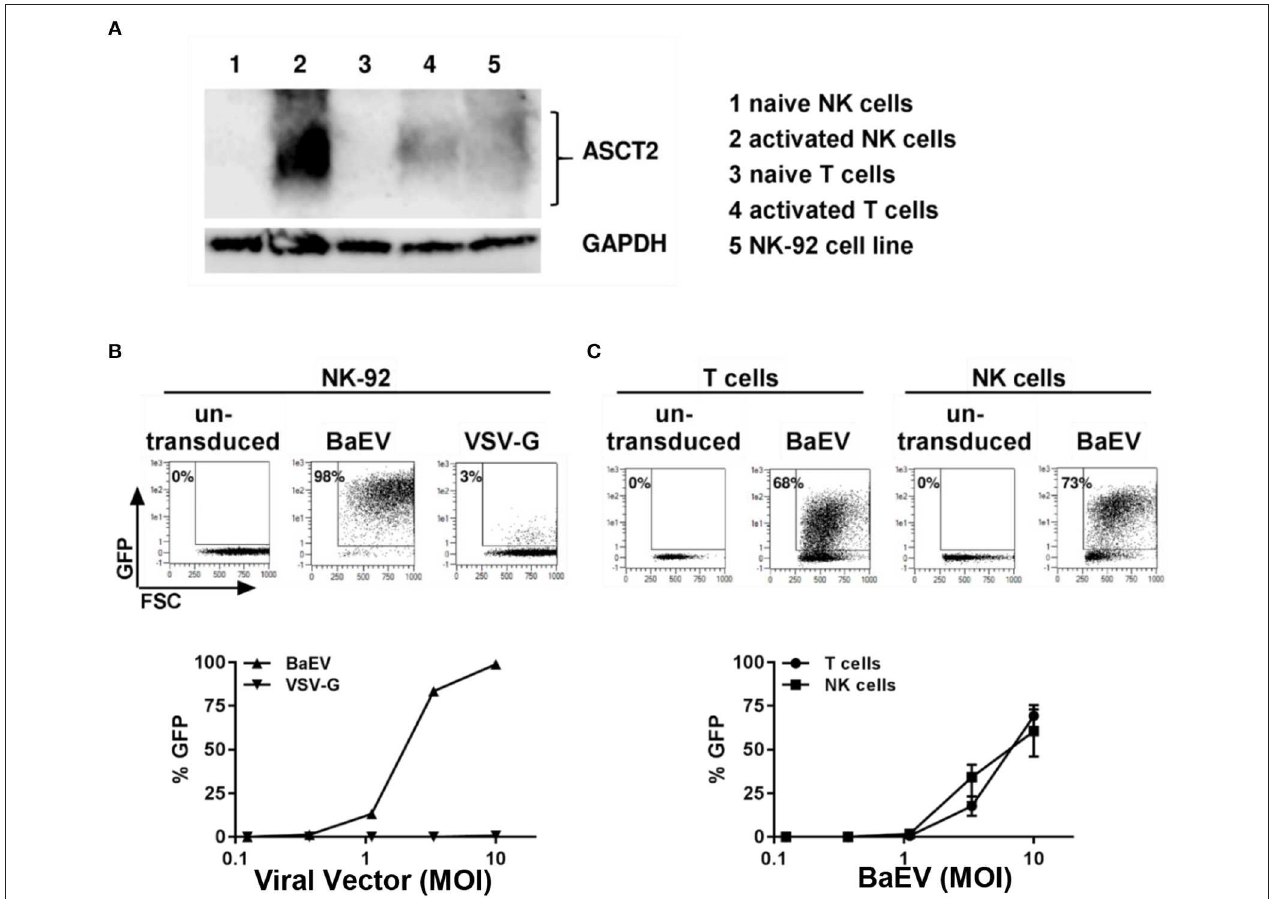
FIGURE 2 | Activated but not naive NK and T cells expressed the receptor for baboon envelope ASCT2. NK cells were activated by growing them in NK-MACS medium (Miltenyi Biotec GmbH) with IL-2 and IL-15 for 2 days. T cells were activated with transact beads. (A) Naive and activated NK and T cells as well as NK 92 cell line were lysed in RIPA lysis buffer and subjected to westernblot analysis using antibody against ASCT2. GAPDH was used as loading control. (B) NK92 cell line was transduced with BaEV and VSV-G pseudotyped lentiviral vector containing GFP. Percentage of transduction at MOI 10 are shown in upper part of the figure. Transduction at different MOI are shown in lower part of the figure. (C) Non-transduced and transduced activated NK and T cells were perform using BaEV-LVs containing GFP. Comparison of activated NK and T cells transduction with different MOI of BaEV-LVs are shown in lower part of the